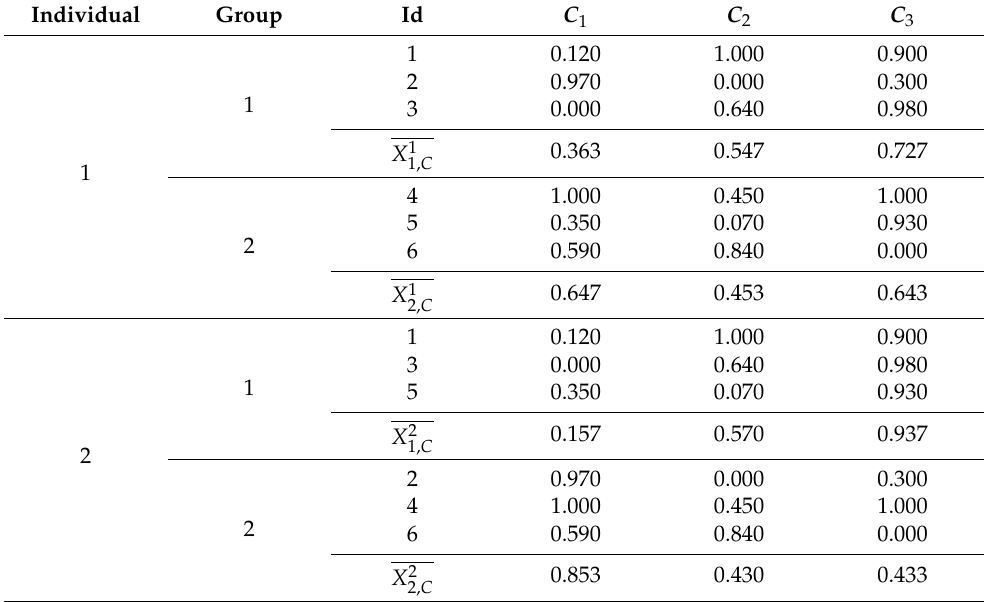
Table 6. X i g , C